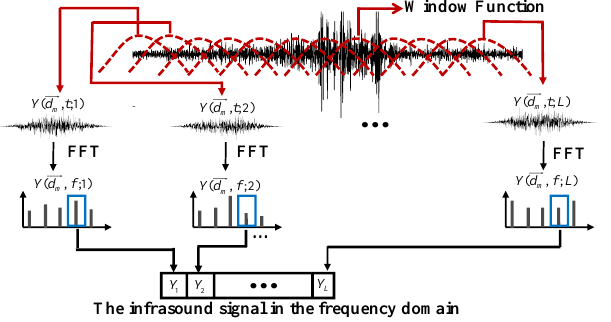
Figure 8. The process of converting infrasound signals from the time domain to the frequency domain using the snapshot method. The variable (cid:126) d m is the observed position of the m -th sensor, and the variable L is the total number of